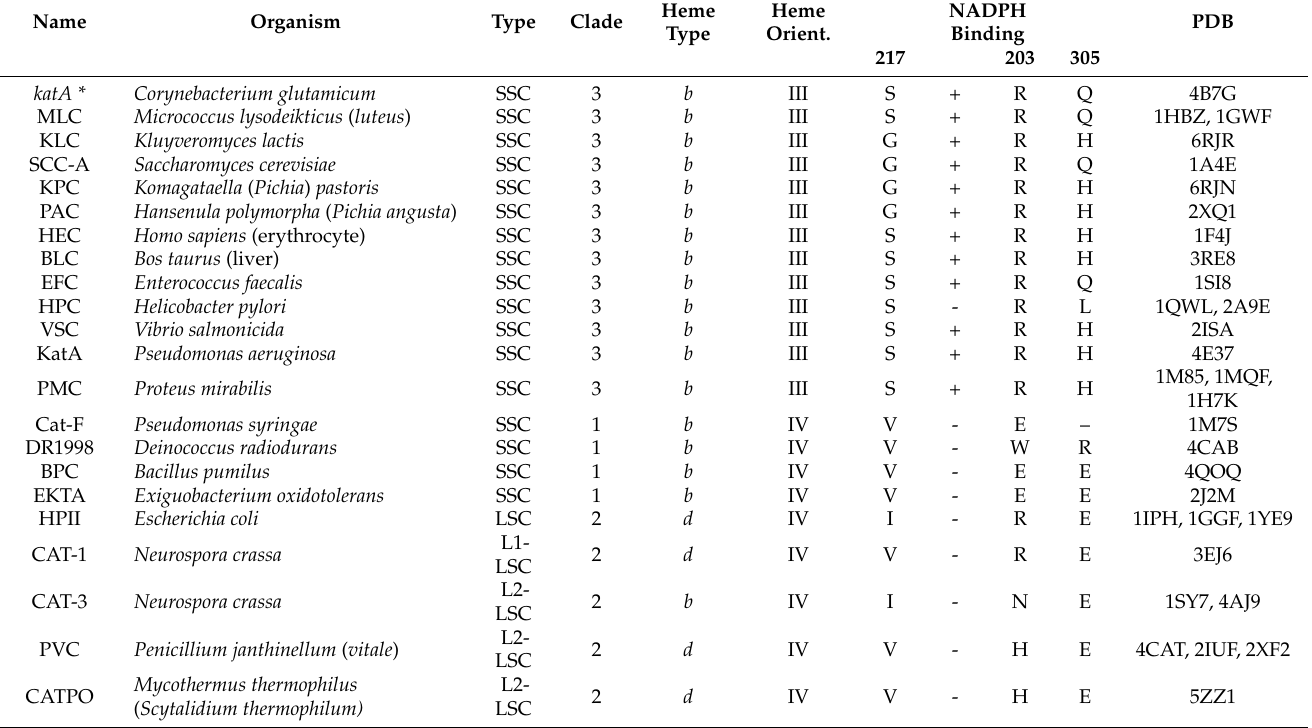
Table 1. Catalase structures and their